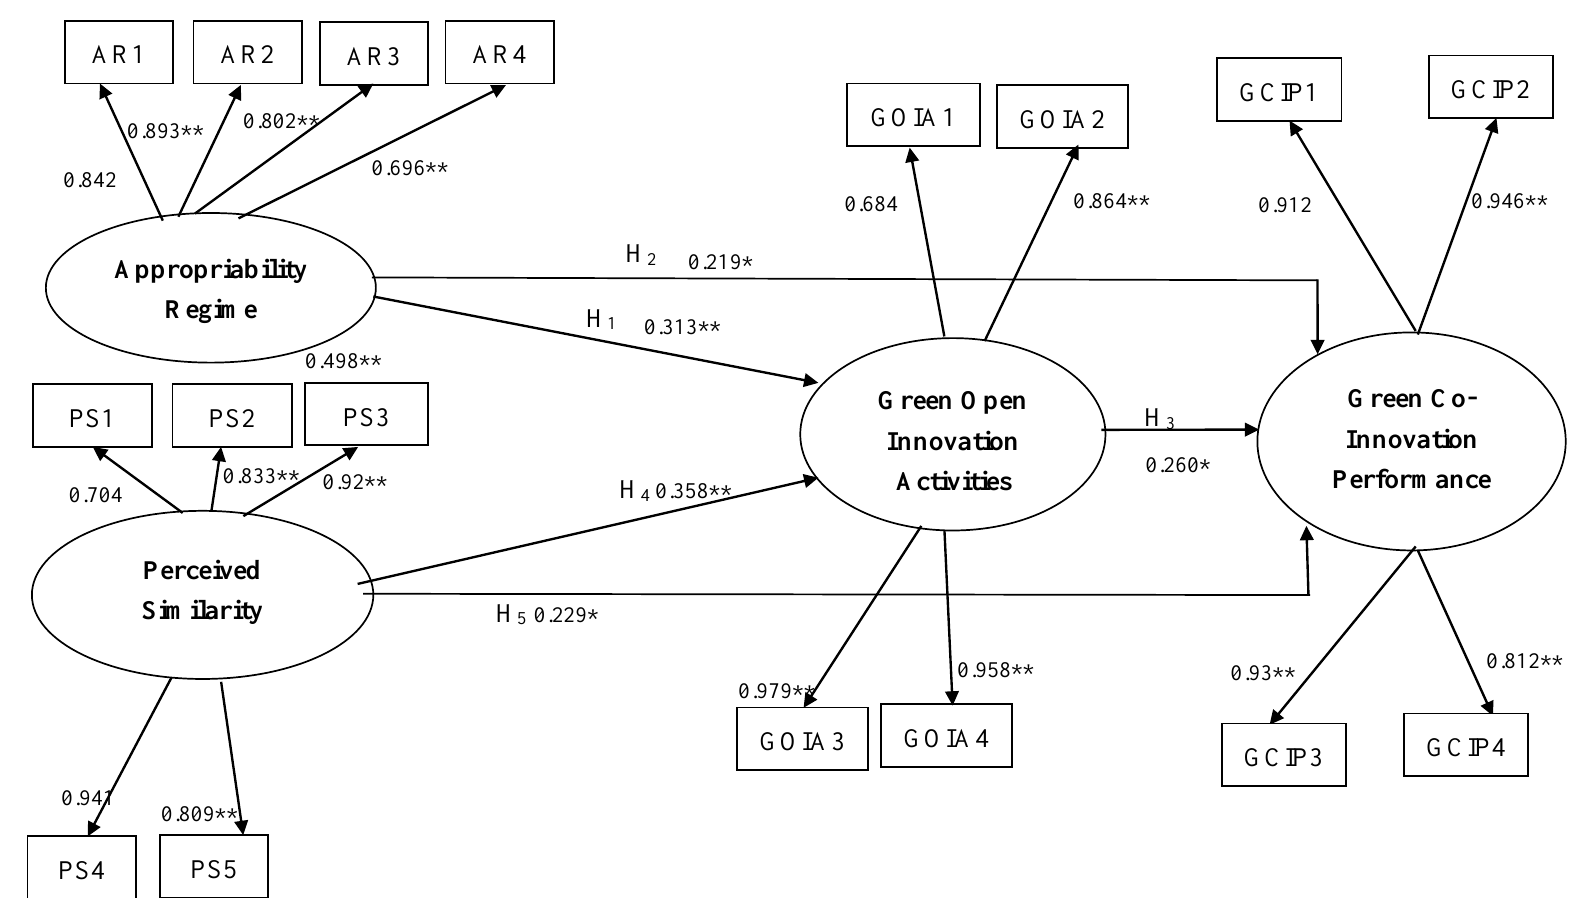
Figure 2. Full model results. Note: goodness of fit (GFI) = 0.901; normed fit index (NFI) = 0.939; root mean square error of approximation (RMSEA) = 0.062. * p < 0.05, ** p < Fig. 2 Full model results